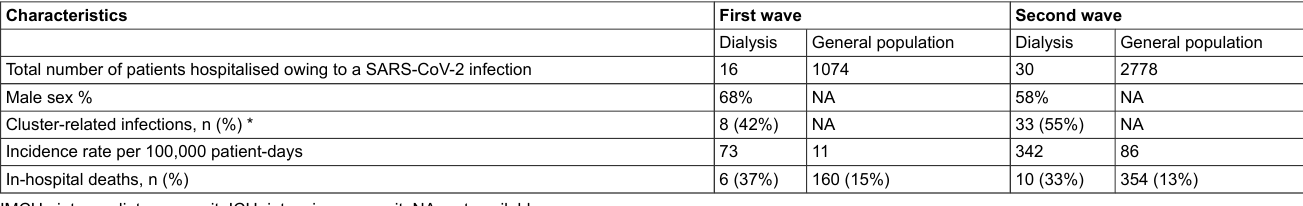
Table 3: Comparison of hospitalised patients on maintenance dialysis with SARS-CoV-2 pneumonia during each wave of the local epidemic.